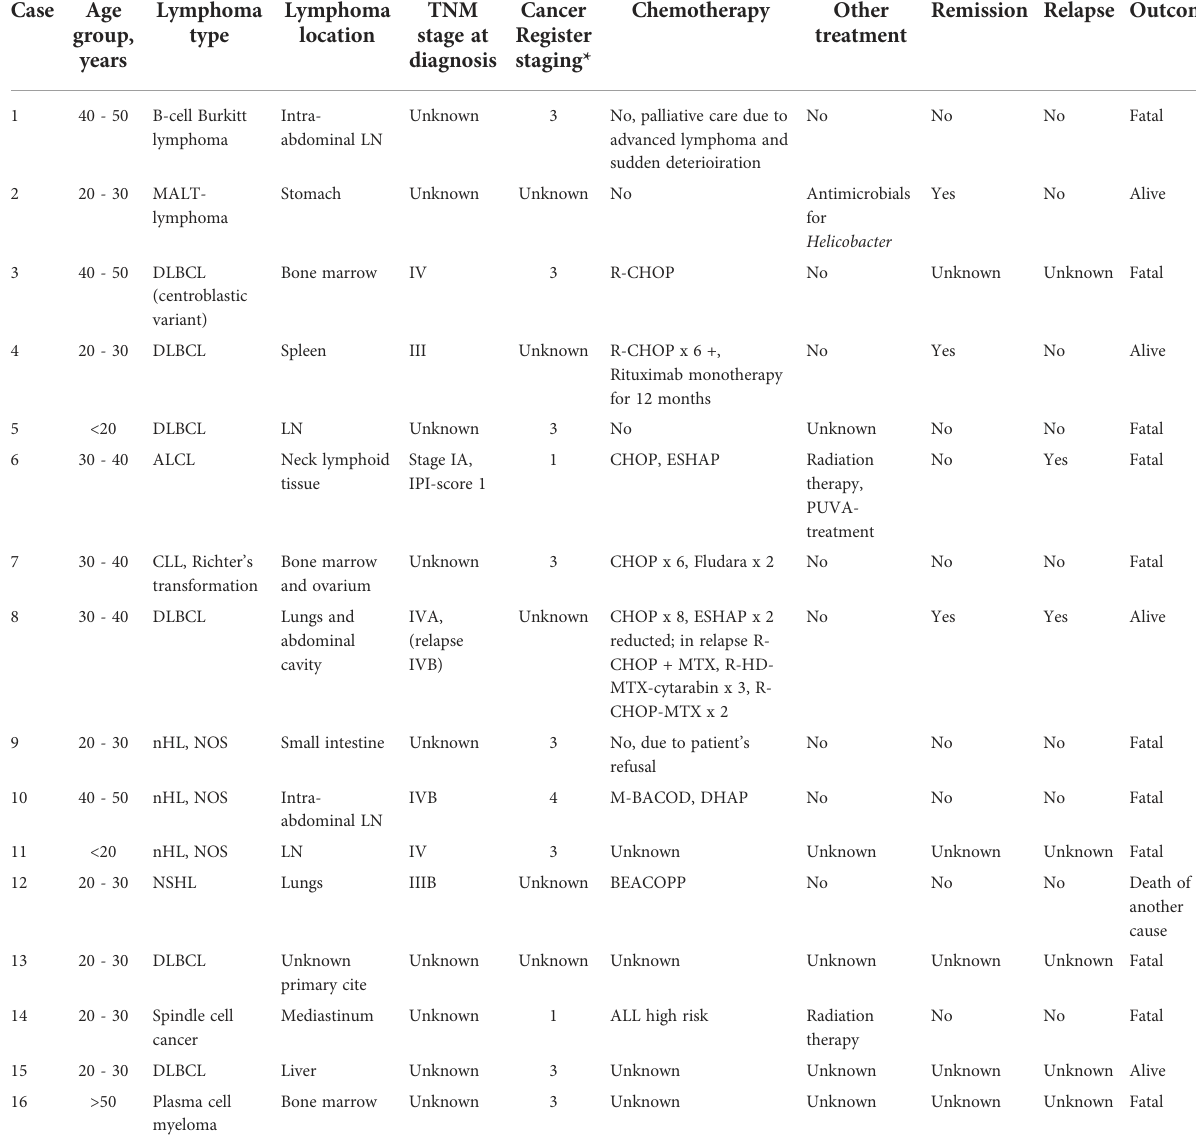
TABLE 2 Description of lymphoid malignancies in study